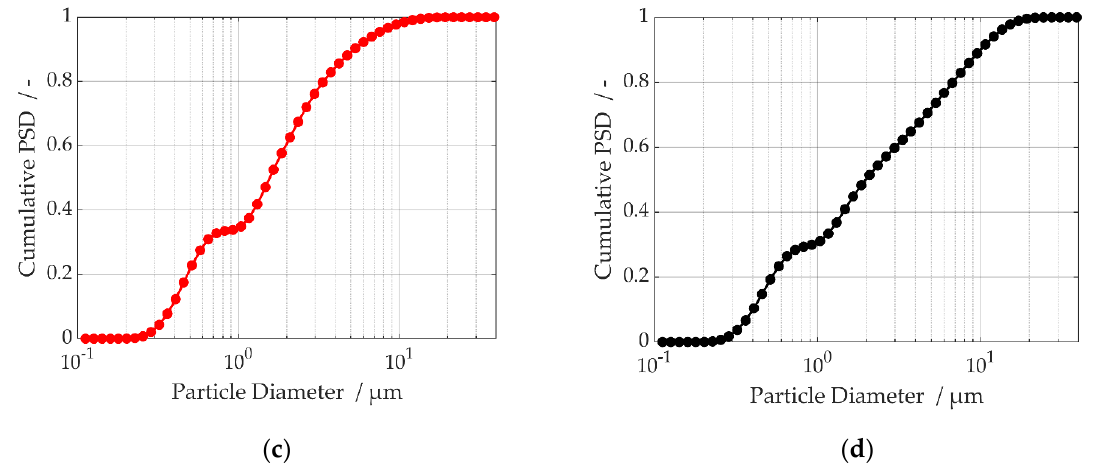
Figure 3. Feed particle size distributions used in the three cases. Blue: 20,000 rpm (Case 1); Red: 40,000 rpm (Case 2); Black: Increasing rotational speed (Case 3). ( a ) Characteristic particle sizes, squares: x 10 ; triangles: x 50 with dashed lines as guides to the eye; stars: x 90 . ( b – d ) Detailed particle size distributions for the three cases, averaged.